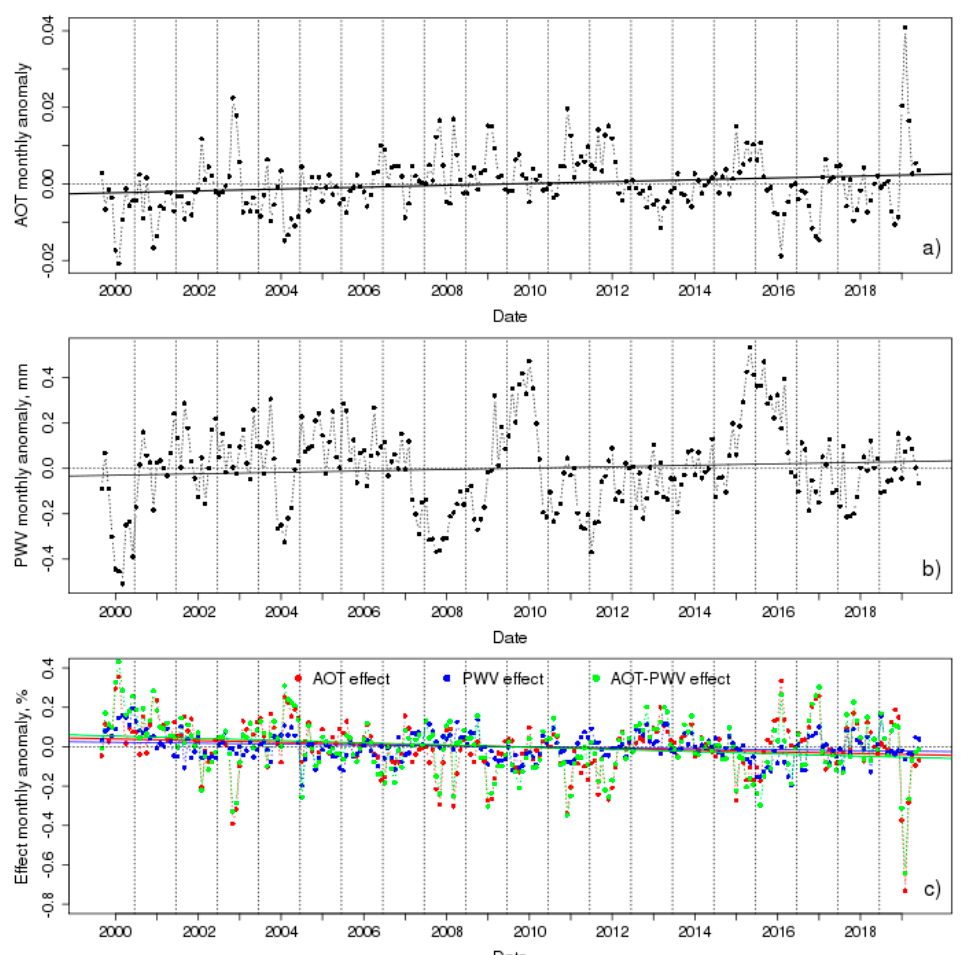
Figure 10. Evolution of monthly mean values of ( a ) AOT, ( b ) PWV, ( c ) AOT effect, PWV effect and AOT-PWV effect anomalies from March 2000 to December 2019.